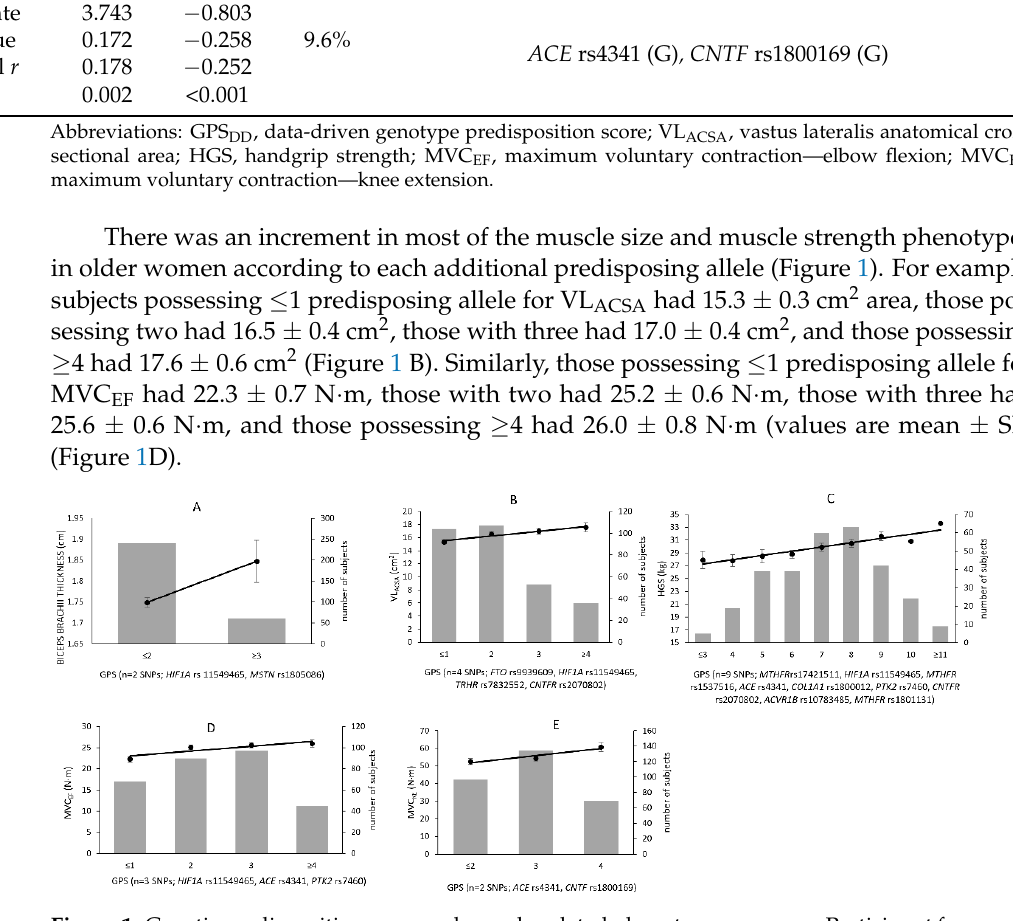
Figure 1. Genetic predisposition score and muscle-related phenotype measures. Participant frequency distribution (bars) and GPS (line) for ( A ) biceps brachii thickness, ( B ) VL ACSA (vastus lateralis anatomical cross-sectional area), ( C ) HGS (hand grip strength), ( D ) MVC EF (elbow flexion maximum voluntary contraction), and ( E ) MVC KE (knee extension maximum voluntary contraction). Dot and error bar represent mean and standard error of the mean, respectively.